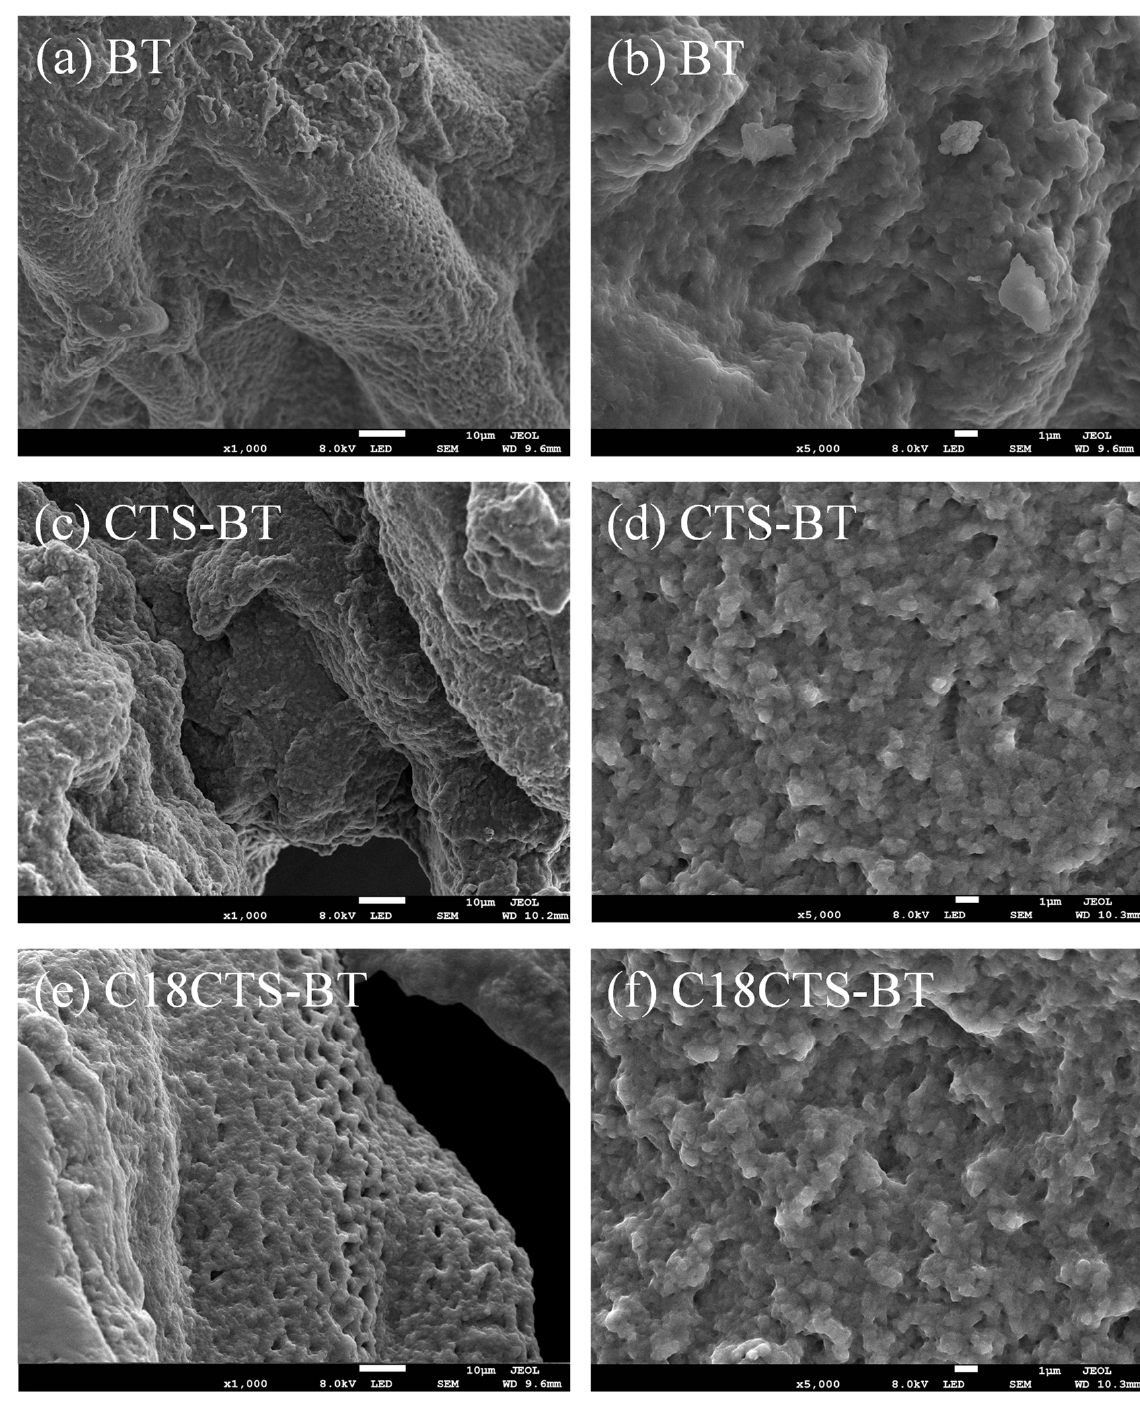
Figure 4. SEM photographs of the adsorbents.